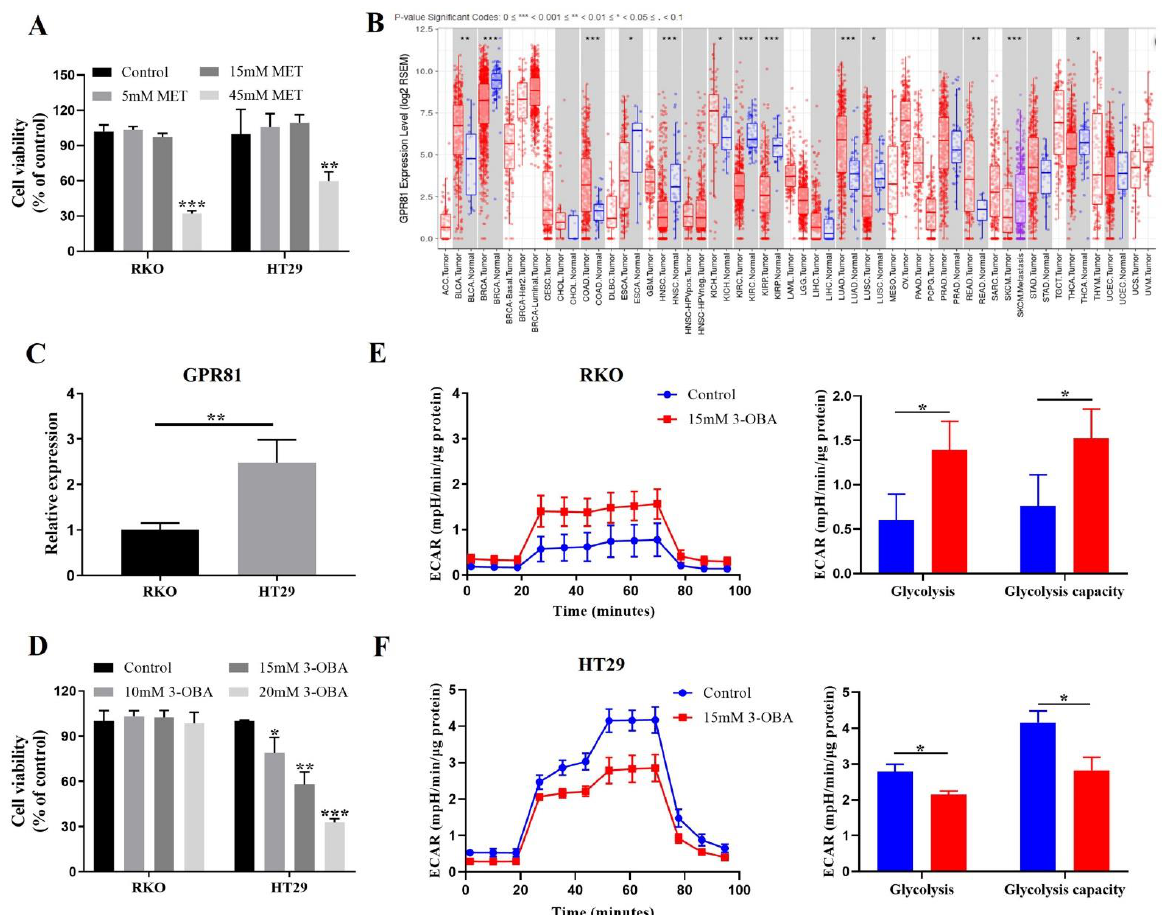
Figure 1. Effects of metformin and 3-OBA on cell proliferation and metabolism. ( A ) RKO and HT29 cells were treated with various concentrations of metformin (5 mM, 15 mM, 45 mM) for 48 h. Cell viability was measured by CCK-8 assay. ( B ) GPR81 expression of a wide variety of cancers in TIMER. ( C ) Relative mRNA expression of GPR81 in RKO and HT29 cells. ( D ) RKO and HT29 cells were treated with different concentrations of 3-OBA (10 mM, 15 mM, 20 mM) for 48 h. Cell viability was measured by CCK-8 assay. ( E , F ) Extracellular acidification rate (ECAR) of RKO ( E ) or HT29 ( F ) cells pretreated with 15 mM 3-OBA was detected in the presence of glucose, oligomycin (OM), and 2-deoxy glucose (2-DG). Representative histograms of at least three independent experiments are shown. * p < 0.05, ** p < 0.01, *** p <